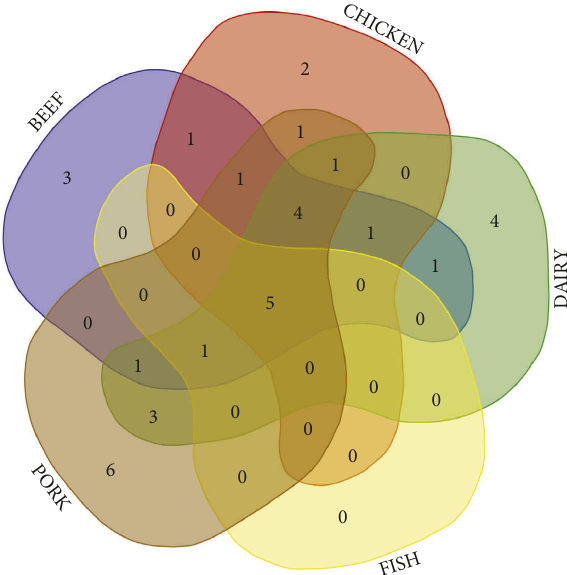
Figure 2: Listeria monocytogenes antimicrobial resistance across different animal production chains. PORK ( n � 6): benzylpenicillin, cefotaxime, cephalosporin, doxycycline, fusidic acid, and